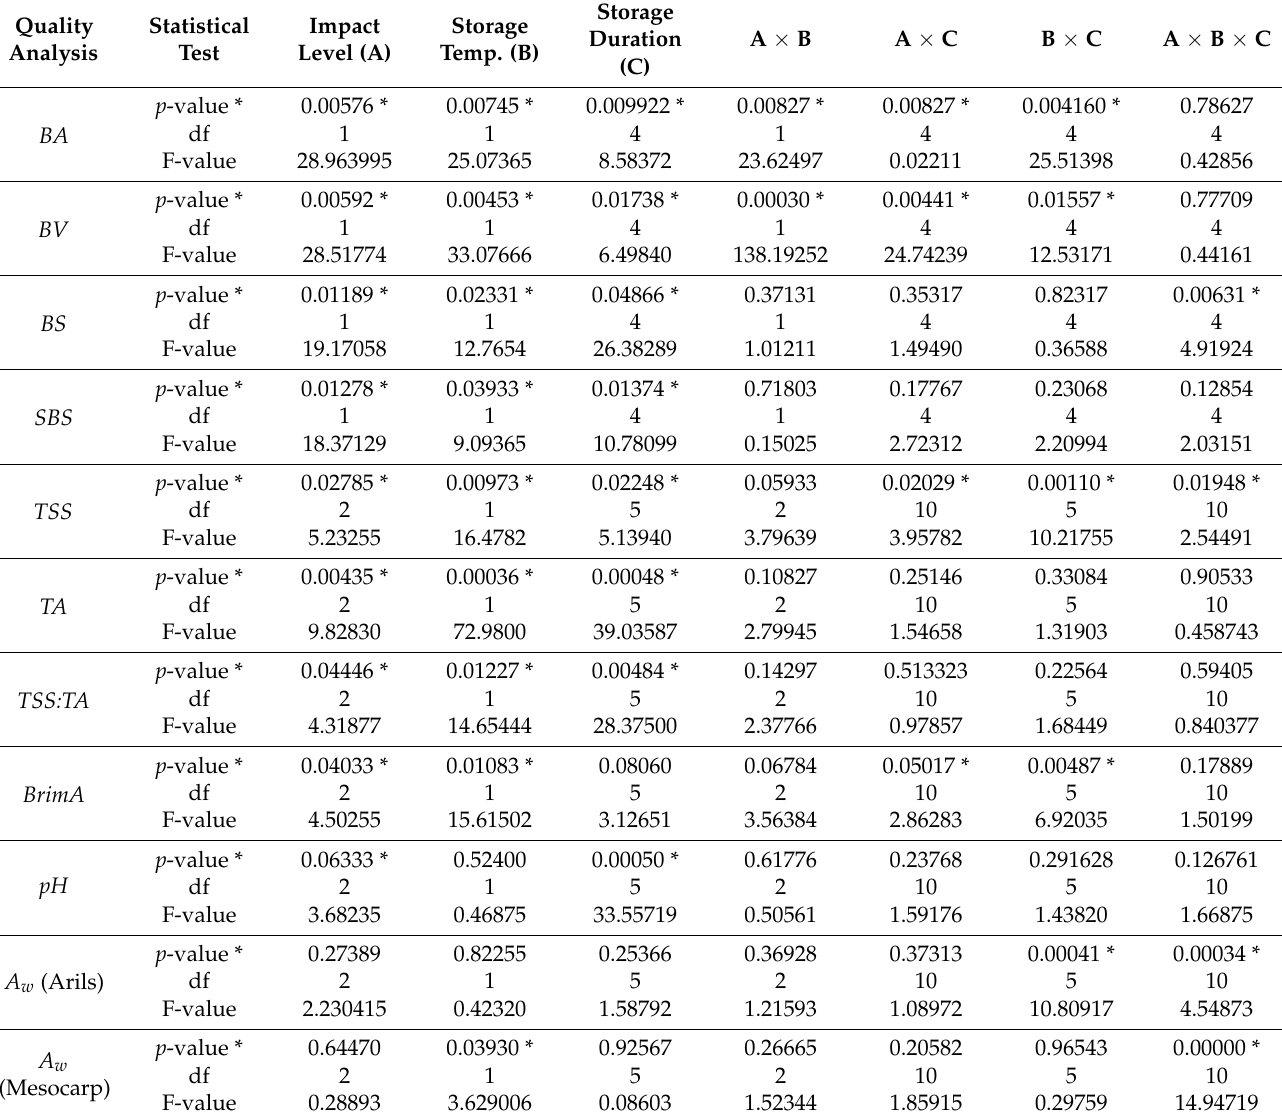
Table 1. The statistical analysis of bruise area ( BA ), bruise volume ( BV ), bruise susceptibility ( BS ), specific bruise sensitivity ( SBS ), total soluble solids ( TSS ), titratable acidity ( TA% ), sugar:acid ratio ( TSS:TA ), BrimA , pH , and water activity ( A w ) (arils and mesocarp) of non-bruised, low- (45 ◦ ; 1.18 J), and high-impact (65 ◦ ; 2.29 J) bruised pomegranate fruit over 28 days stored at 5 ◦ C and 22 ◦ C. Data were subjected to a three-way analysis of variance (ANOVA) (Factor A: impact level, Factor B: storage temperature, Factor C: storage duration). * Significant at p ≤ 0.05; df = degree of